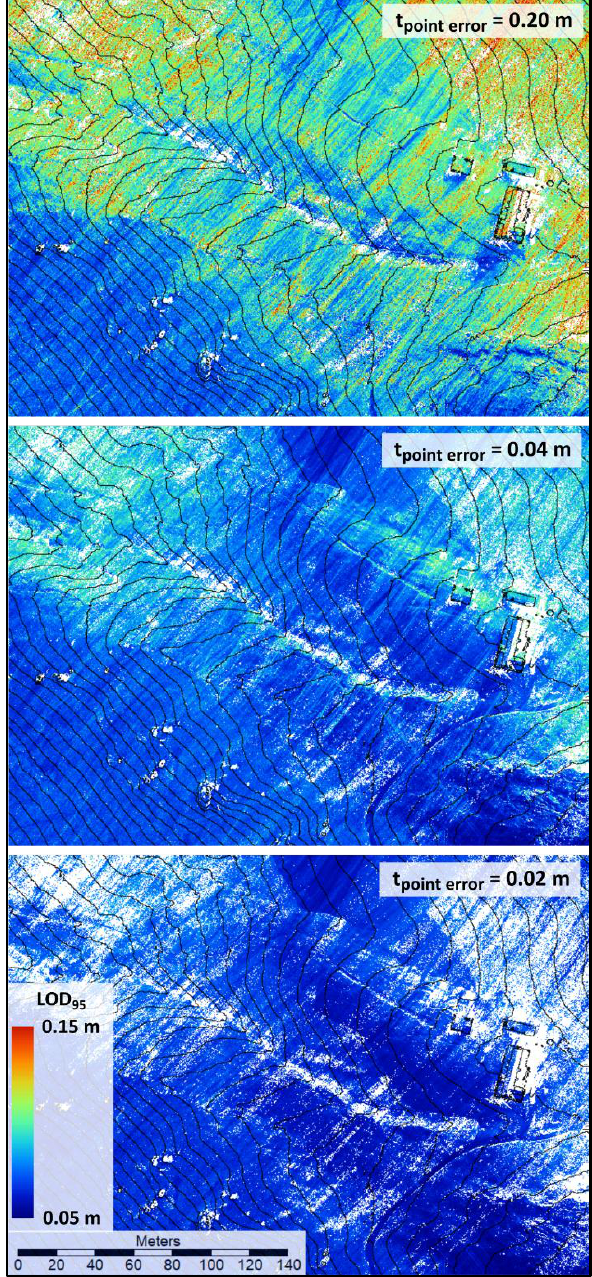
Figure 6. LOD 95 maps of the test site subset with three different filtering thresholds for the point error (t point error ). For visualization, the point cloud attribute values for the LOD 95 were aggregated to rasters with 0.1 m cell size, by calculating the arithmetic mean per cell. White areas represent cells without points with a valid distance and LOD 95 calculation. Contour equidistance is 5